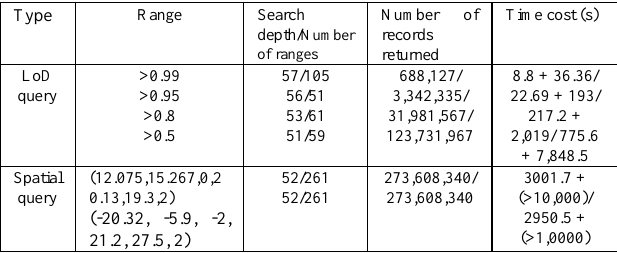
Table 5. Query performance of the IOT solution. The first part of time cost is query time including writing into the